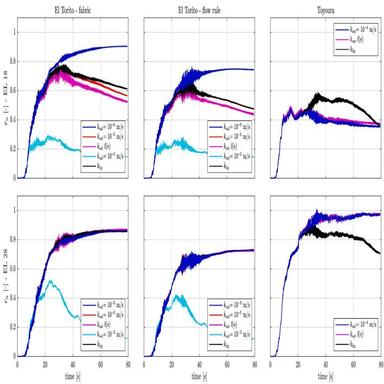
Excess pore water pressure ratio time-histories at elements 18 (top row) and 28 (bottom row) for both sands and calibrations.